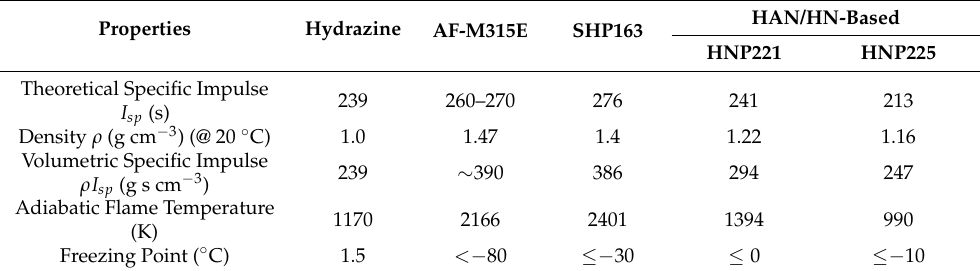
Table 3. Physical properties and performance (@ 1 MPa chamber pressure, 100:1 expansion